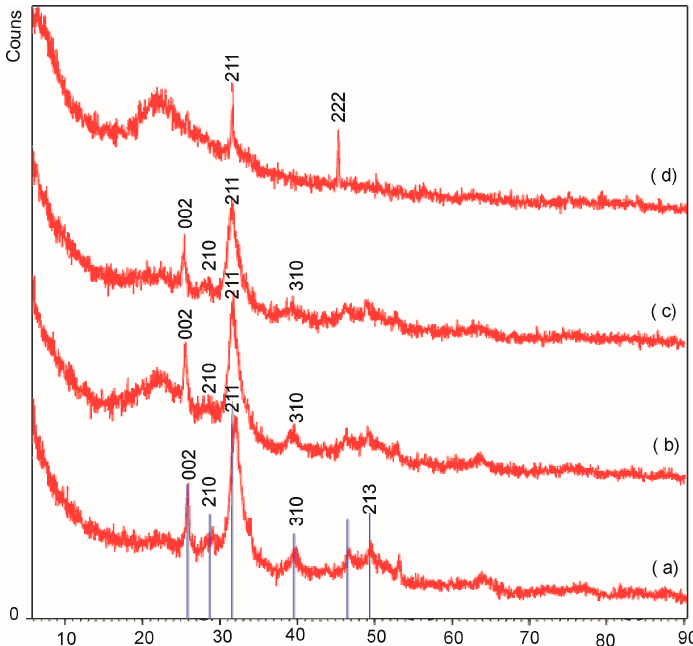
Figure 5. X-ray diffraction (XRD) patterns of ( a ) MCM-41 ( b ) MCM-epoxy, ( c ) MCM-SH, and ( d ) MCM-NH 2 after 2 weeks of mineralization studies in simulated body fluid.